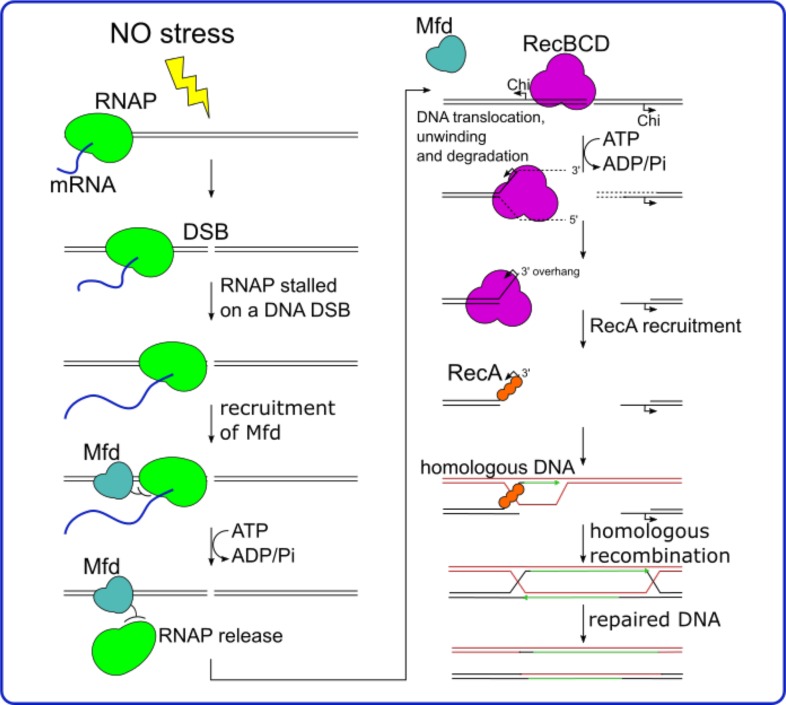
In the context of NO stress, we show that mfd and recBC/addAB deletions are epistatic.As RecBC participates in the repair of Double Strand Breaks (DSB), this indicates that Mfd also participates in DSB repair. It is unlikely that Mfd prevents DSBs because, in that case, RecBC would be essential for DNA repair in a mfd mutant. By contrast, we hypothesized that following the DSBs induced by NO exposure, RecBC has not directly access to Double strand ends (DSEs). Thus, Mfd would act first by removing the RNAP blocked on DNA lesions. Then the RecBCD complex can be recruited to repairs the DSB. RecBCD unwinds the DNA helix and degrades single strands. When RecBDC encounters a Chi site on the DNA, the degradation of the 5’ terminus is enhanced leaving a 3’ overhang and leads to the formation of an ssDNA. RecA binds to ssDNA and promotes repair by recombination with a homologous molecule of DNA [50].